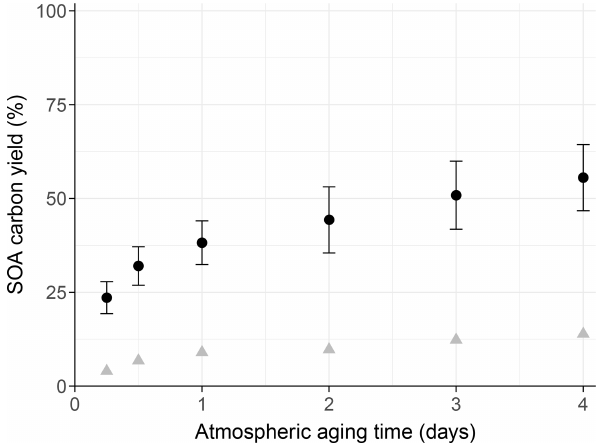
Figure 6. SOA carbon yield from aging of biomass burning emis- sions. Black points are carbon yields using our best estimate of OA carbon mass. Yields are calculated from the ratios of SOA car- bon formed to NMOG carbon reacted (estimated from the average carbon-weighted OH rate coefficient for identified compounds and accounting for chamber dilution). Error bars are ± 1 σ in the slope of the linear fit between SOA and NMOG carbon mass. Gray triangles are estimated yields using AMS CE = 1 for all OA, both before and after aging, which is a common assumption made in previous stud- ies on the aging of biomass burning. See Supplement (Table S13) for tabulated